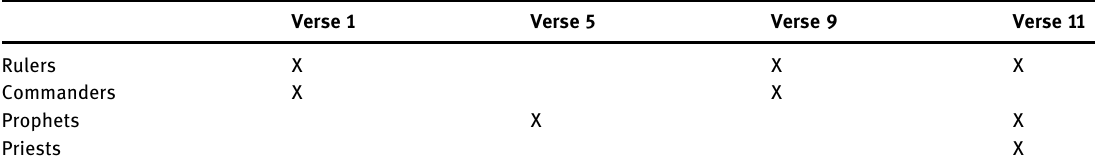
Table 1: Distribution of Leadership Labels in Micah